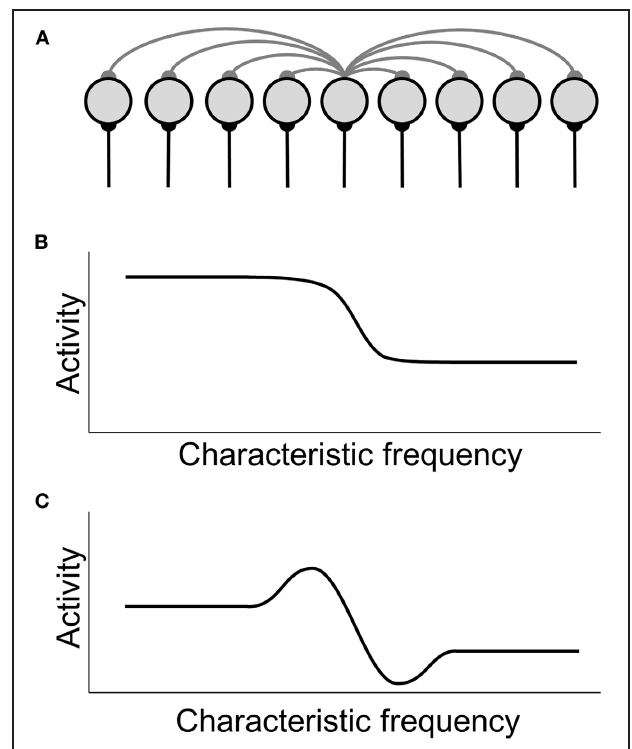
FIGURE 1 | Schematic illustration of lateral-inhibition models. (A) Depiction of a layer of neurons with lateral inhibition. Neurons are represented by gray circles, lateral inhibitory connections by gray lines (only the inhibitory projections from the central neuron to its neighbors are shown), and excitatory afferents by black lines. (B) Hypothetical auditory activity pattern with a drop toward high frequencies, as it could for example occur in the spontaneous activity of the auditory nerve after noise-induced hearing loss. (C) Activity pattern in the lateral-inhibition network driven by the input shown in (B) . An activity peak is generated at the edge of the input pattern but below the region of hearing